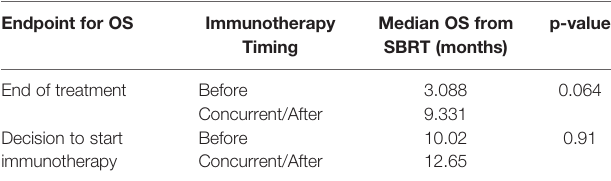
TABLE 4 | Median OS as calculated from the end of treatment (immunotherapy or radiation) or decision to start immunotherapy.